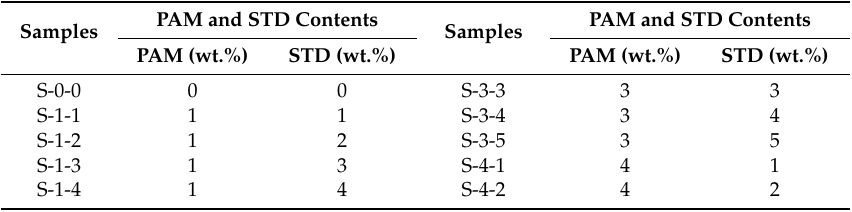
Table 1. Na 2 SO 4 · 10H 2 O–5 wt.% KCl composites with varying contents of polyacrylamide (PAM) and sodium tetraborate decahydrate